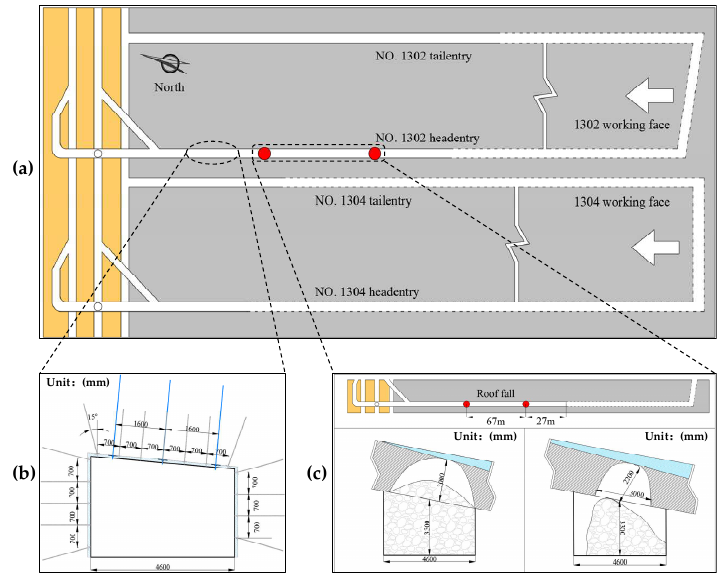
Figure 1. Schematics of mining area roadway layout and roof fall: ( a ) mining area plan; ( b ) original roadway support section; ( c ) diagram of roof fall accident.